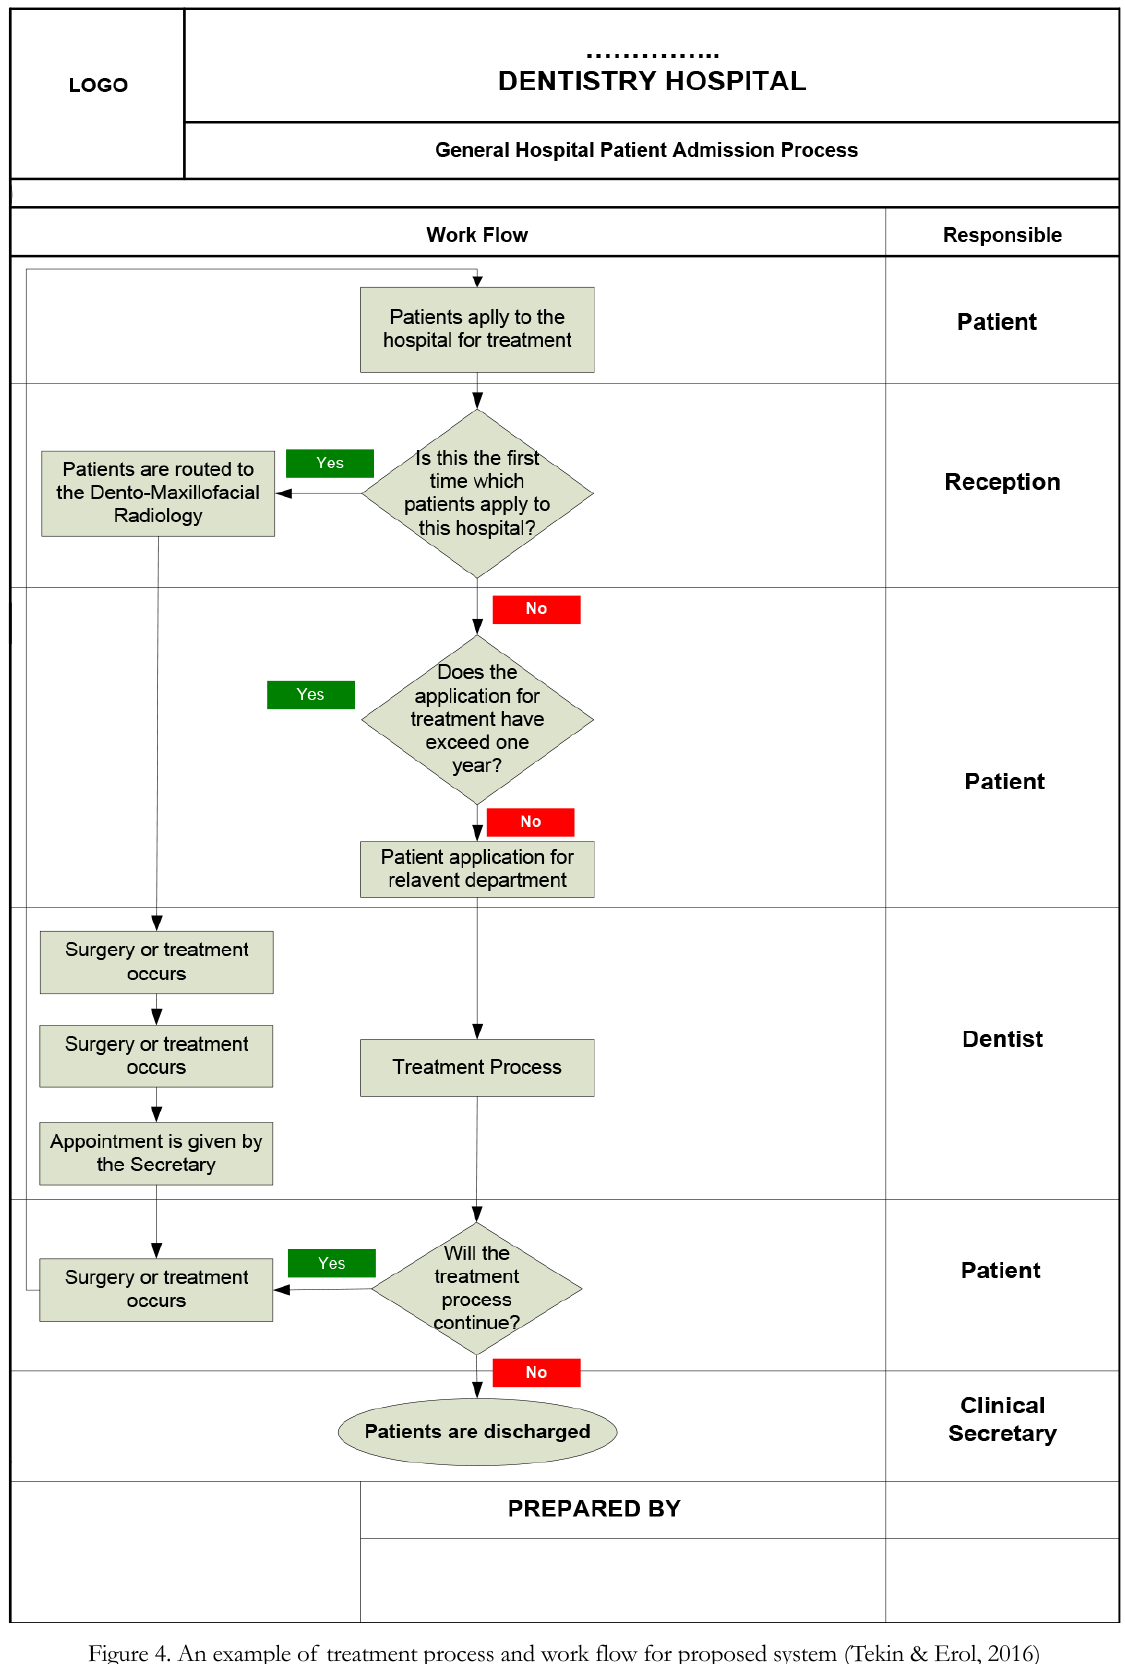
Figure 4. An example of treatment process and work flow for proposed system (Tekin & Erol,